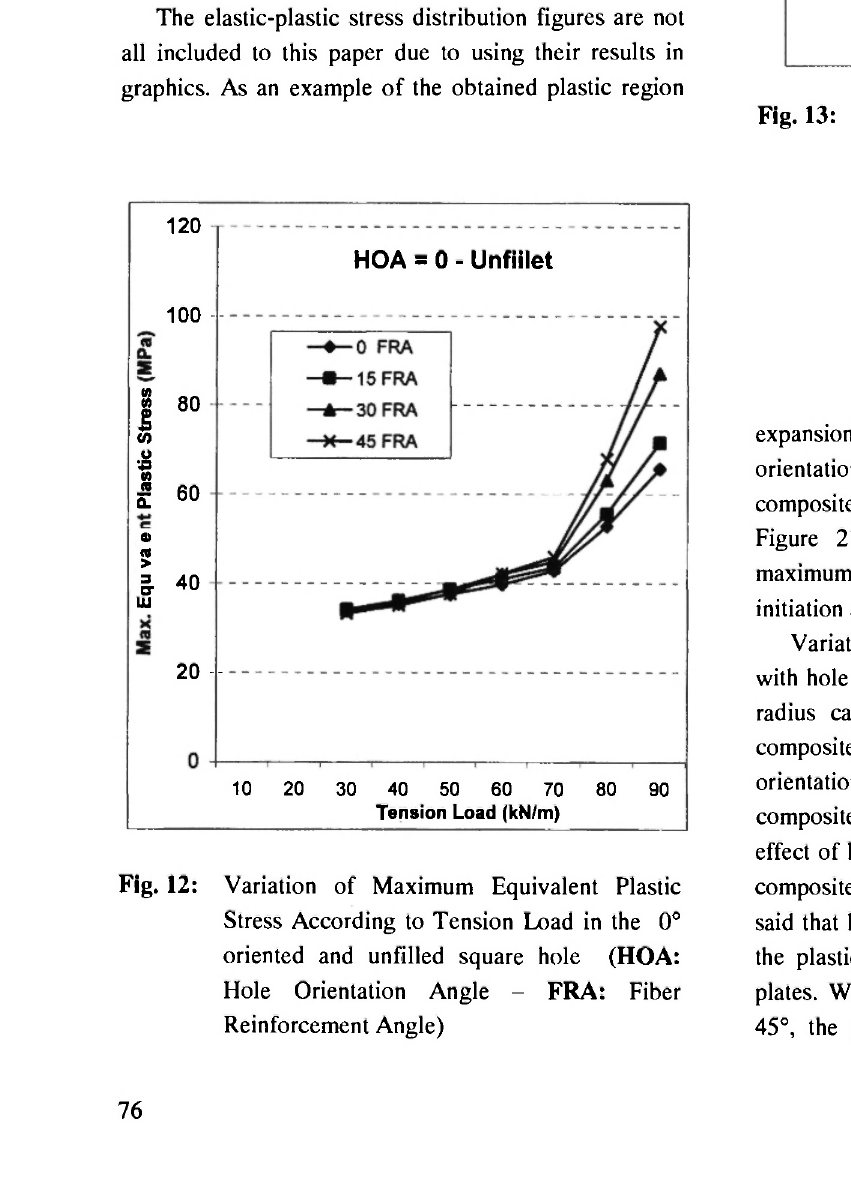
Fig. 12: Variation of Maximum Equivalent Plastic Stress According to Tension Load in the 0° oriented and unfilled square hole (HOA: Hole Orientation Angle - FRA: Fiber Reinforcement Angle)